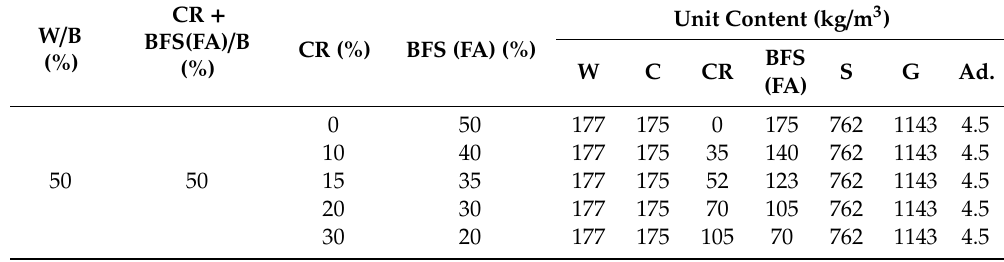
Table 5. Mix proportion of concrete multi-added petroleum coke residue and (slag / fly